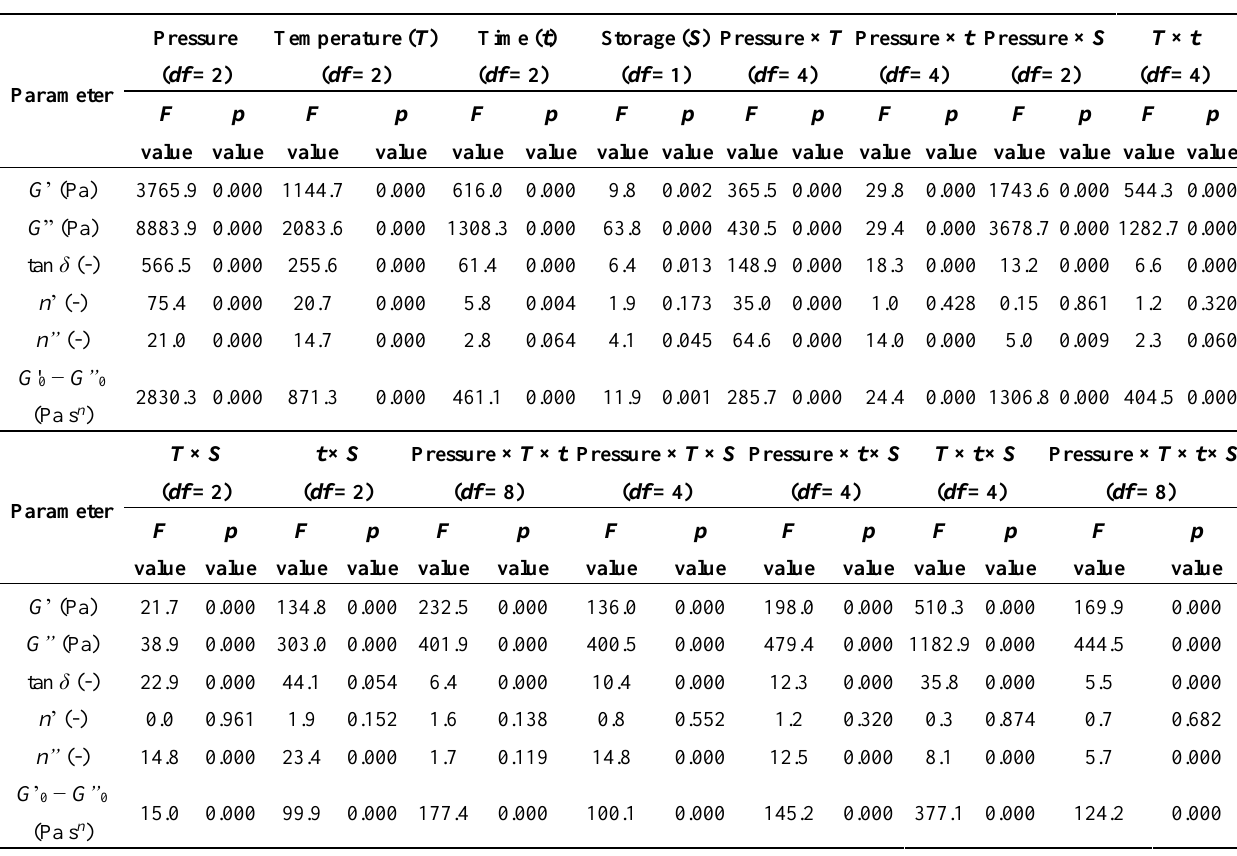
Table 1. Four-way analysis of variance of the rheological properties of heat-induced chickpea flour gel at 75 °C for 15 min derived from mechanical spectra after cooling to 25 °C (high hydrostatic pressure treatments: 200, 400, and 600 MPa; 10, 25, and 50 °C; 5, 15, and 25 min, in samples without and with storage, and unpressurized slurry). F and p